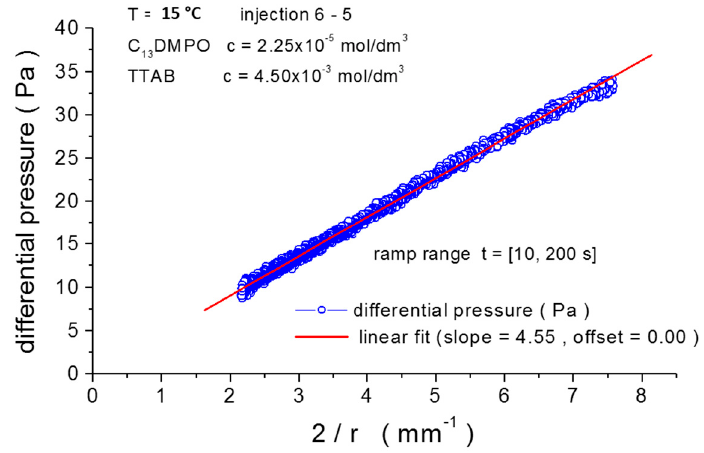
Figure 2. Fitting of differential pressure vs. inverse radius, r, for injection 6-5 at T = 15 °C for a growing drop experiment, with filtered reference pressure and adjusted calibration parameters (linear fit, slope = 4.55 mNm − 1 , offset = 0.00 Pa).